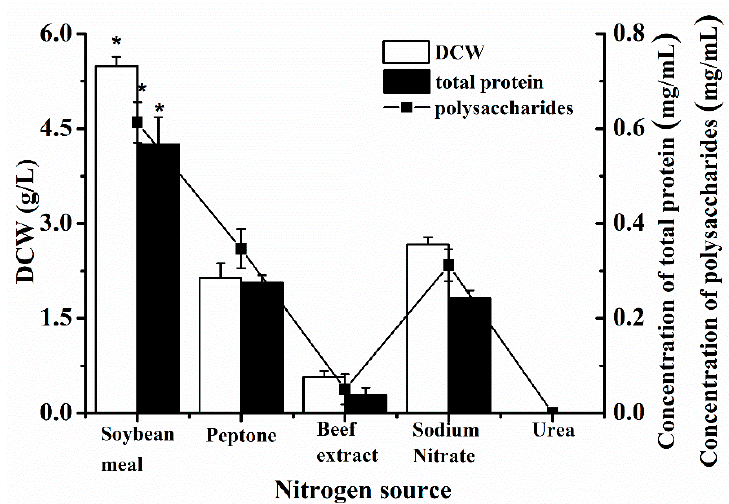
Figure 2. The effect of nitrogen source on the DCW, total protein, and polysaccharides of P. eryngii -3 in shake flask. * Indicates statistical significance ( p < 0.05). Data points are the average of n = 3; error bars represent the standard error of the mean. The samples were harvested at 216 h of fermen- tation.